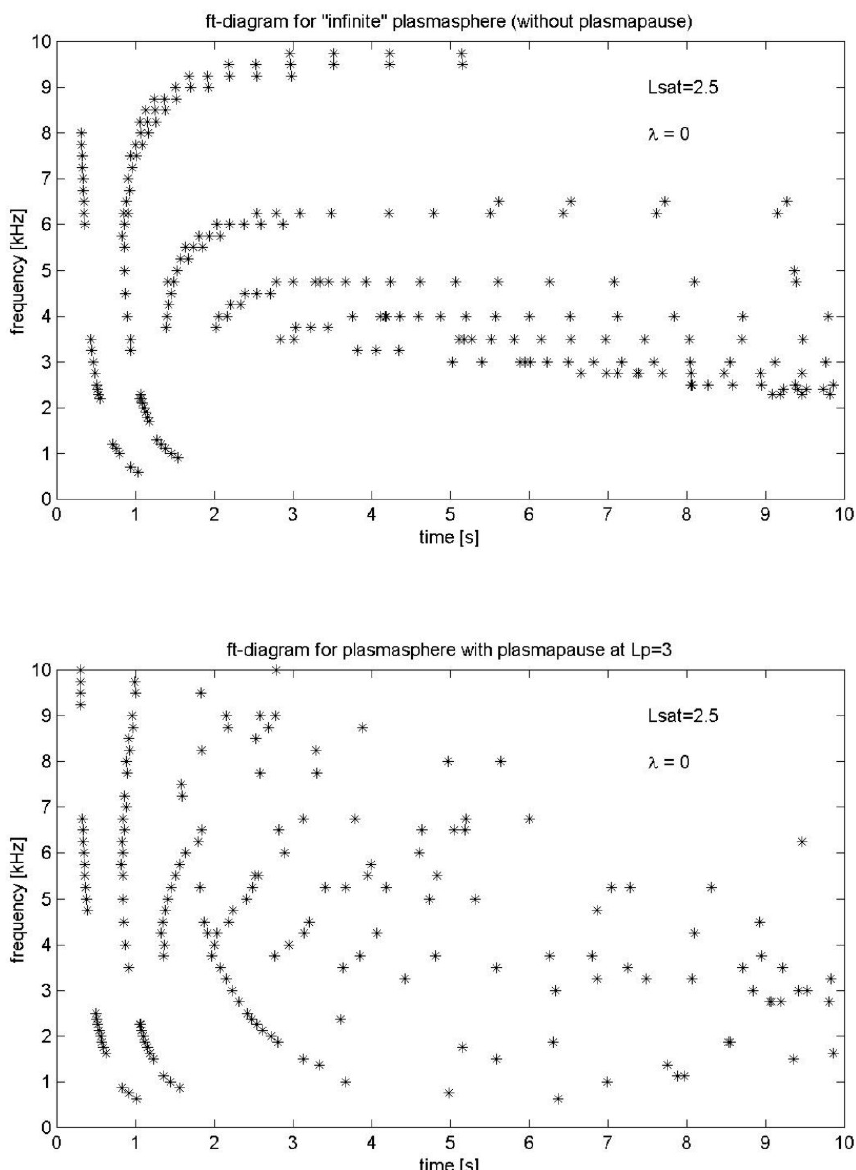
Fig. 10. Comparison of simulated MR whistler spectrograms with (lower panel) and without (upper panel) tak- ing into account the plasmapause, in the case when a satellite is below the